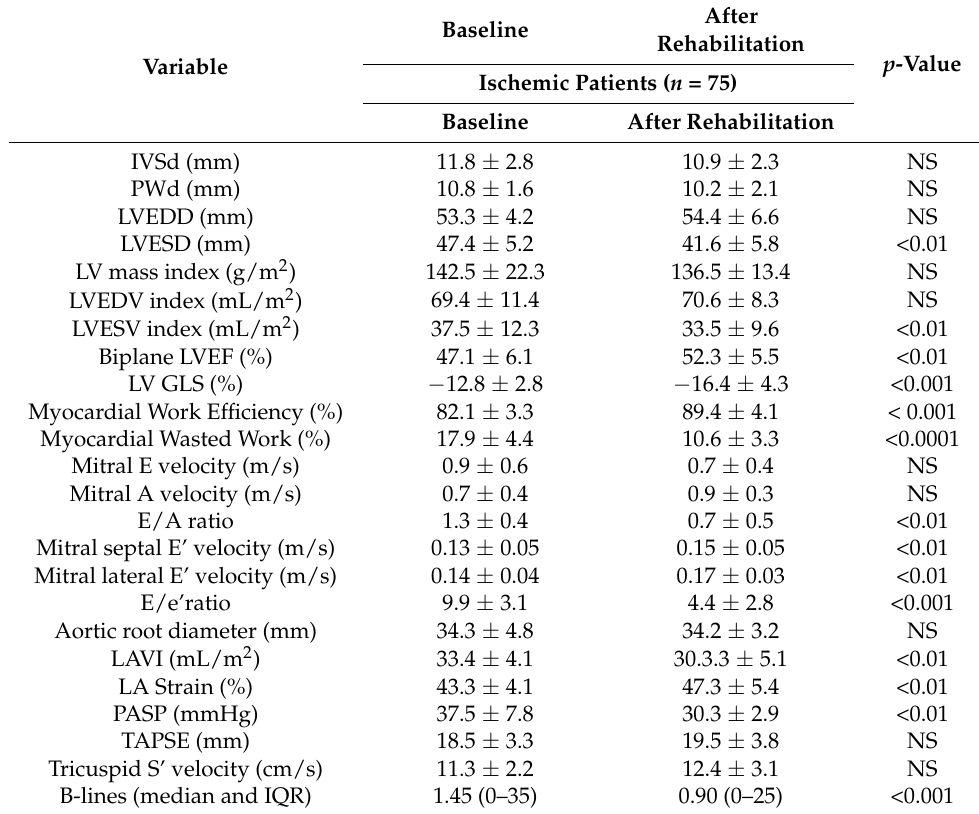
Table 3. Resting echocardiographic and lung ultrasound evaluation in the overall population of ischemic patients at baseline and after cardiac rehabilitation. After Baseline Rehabilitation p -Value Variable Ischemic Patients ( n = 75) Baseline After Rehabilitation